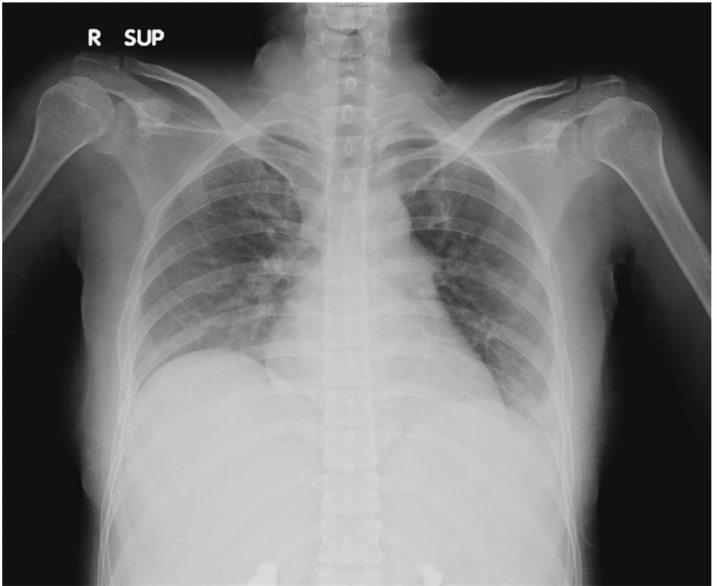
Figure 1. Chest X-ray of patient showing mild left pleural